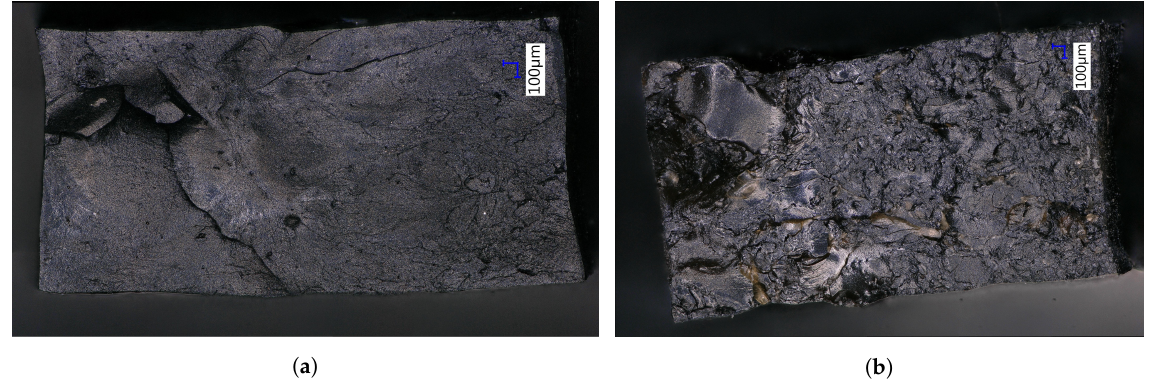
Figure 11. Microscopy pictures of fracture surfaces of dumbbells after tensile tests of revulcanized, carbon black-based and silica-based modelcompounds. Samples 4 mm × 2 mm. ( a ) 80 phr carbon black. ( b ) 90 phr